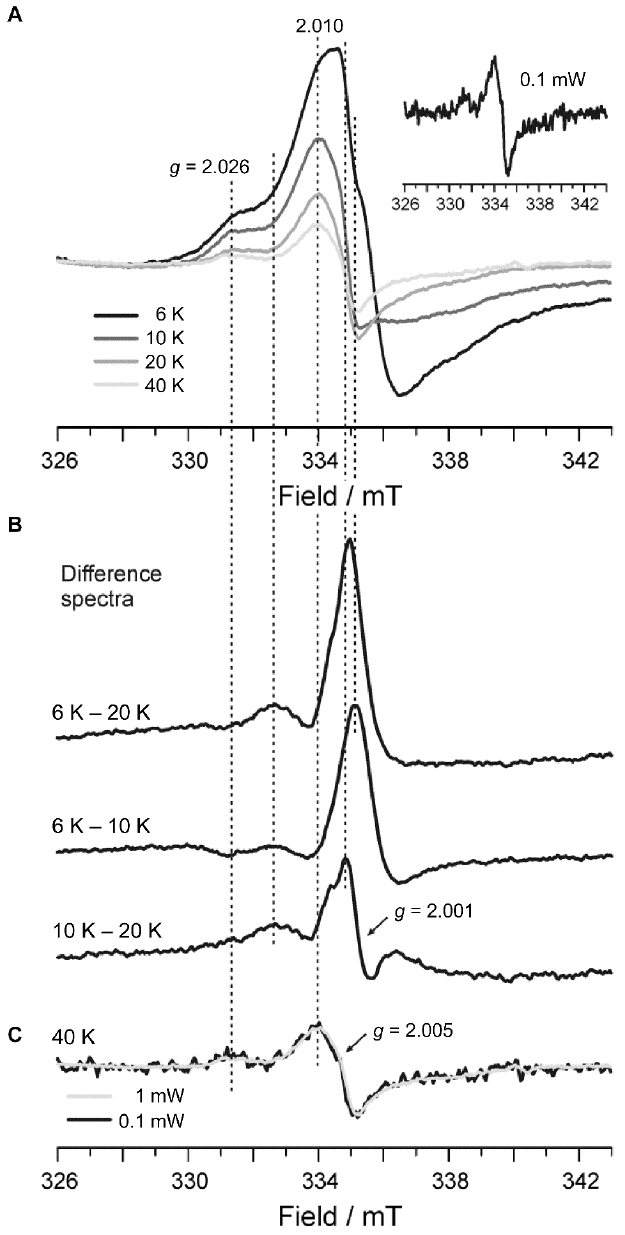
Figure 3. EPR analysis of organic radical formation in Dictyostelium DyPA after addition of H 2 O 2 . ( A ) Temperature dependence of the g ≈ 2.00 signal originating from organic radicals observed in Dictyostelium DyPA after reaction with H 2 O 2 . The right inset shows the spectrum recorded at 40 K under nonsaturating conditions (microwave power = 0.1 mW, modulation amplitude = 0.1 mT, 15 averages) from the same sample. ( B ) Difference spectra from the temperature dependence data shown in panel A, corrected for temperature effects on the signal amplitude (due to temperature effects on the Boltzmann distribution of spin states). The (6–20 K) difference spectrum contains all components stable at T < 20 K, and the (6–10 K) difference spectrum the components stable only at T < 10 K. The (10–20 K) difference spectrum shown at the bottom consequently displays those components still present at 10 K but absent at 20 K. ( C ) Overlay of the 40 K spectra recorded with microwave powers of 1 mW (from panel A ) and 0.1 mW (from inset in panel A ). The 1 mW 40 K spectrum resembles the 20 K spectrum besides its lower amplitude. The small signal at g = 1.974 ( B ≈ 340 mT) observed in the spectra recorded at 40 K is not further addressed here due to its very low intensity. Vertical lines (dashed) are drawn to guide the